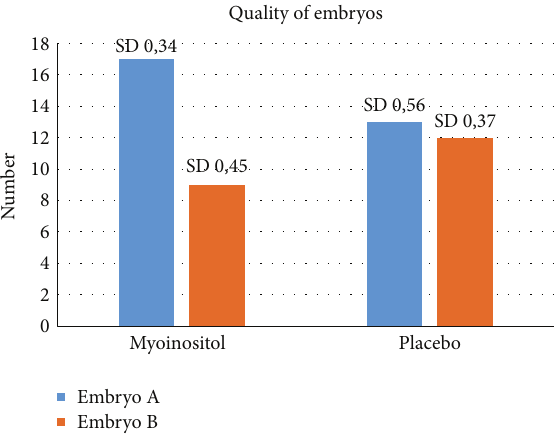
Figure 4: Embryo quality after treatment with myoinositol or placebo. Higher number of embryos with grade I were observed in the myoinositol group ( 𝑝 < 0.05